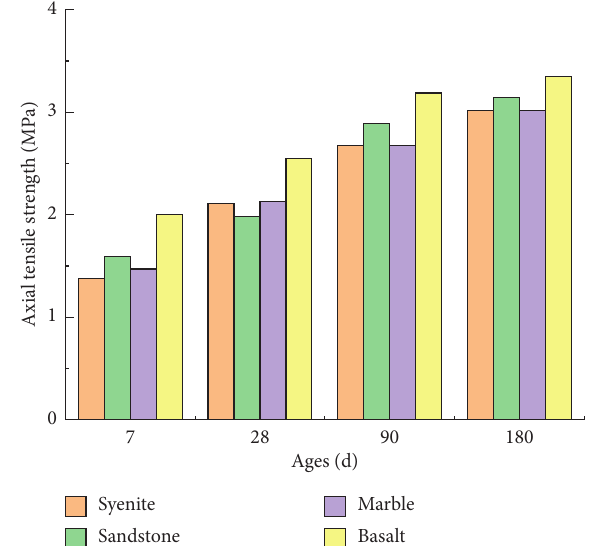
Figure 3: The axial tensile strength of four types of aggregate